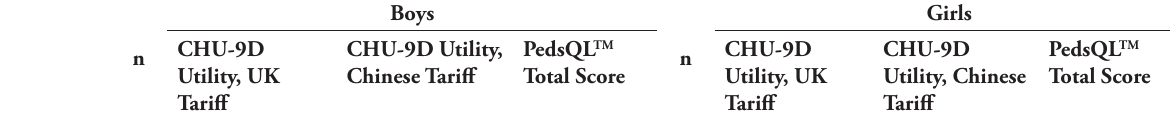
Table 4. Mean (SD) and Median (IQR) for CHU-9D and PedsQL™ Scores Based on Weight Status by